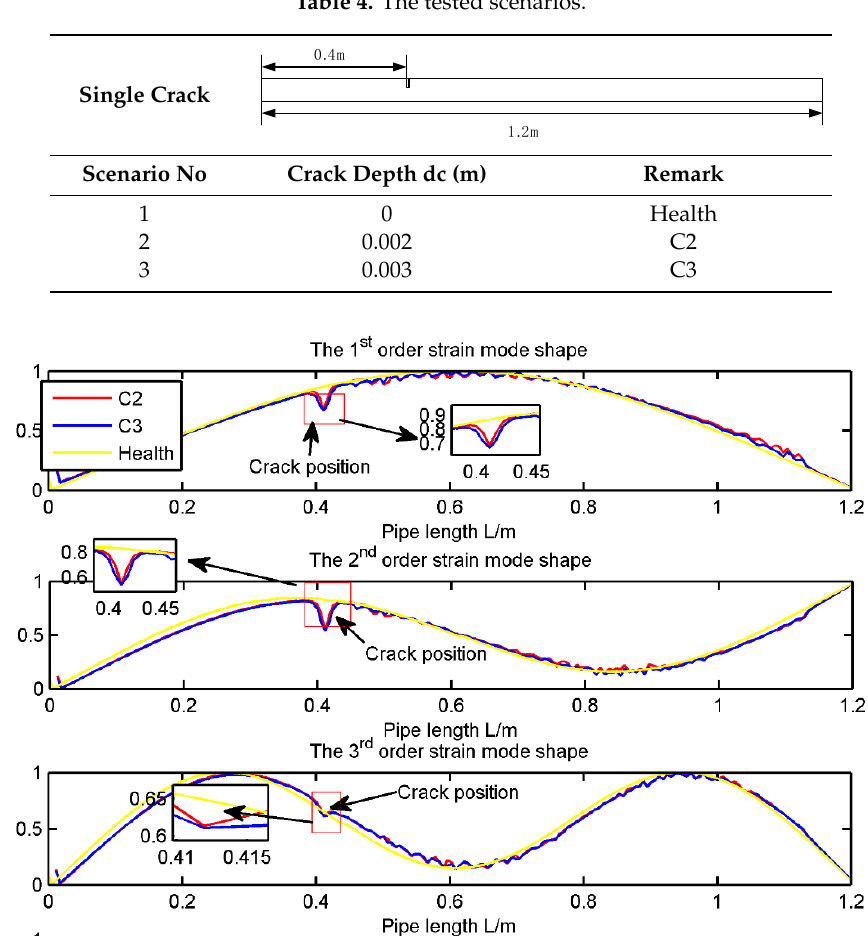
Figure 6. The first three strain mode shapes for all the scenarios listed in Table. 4.